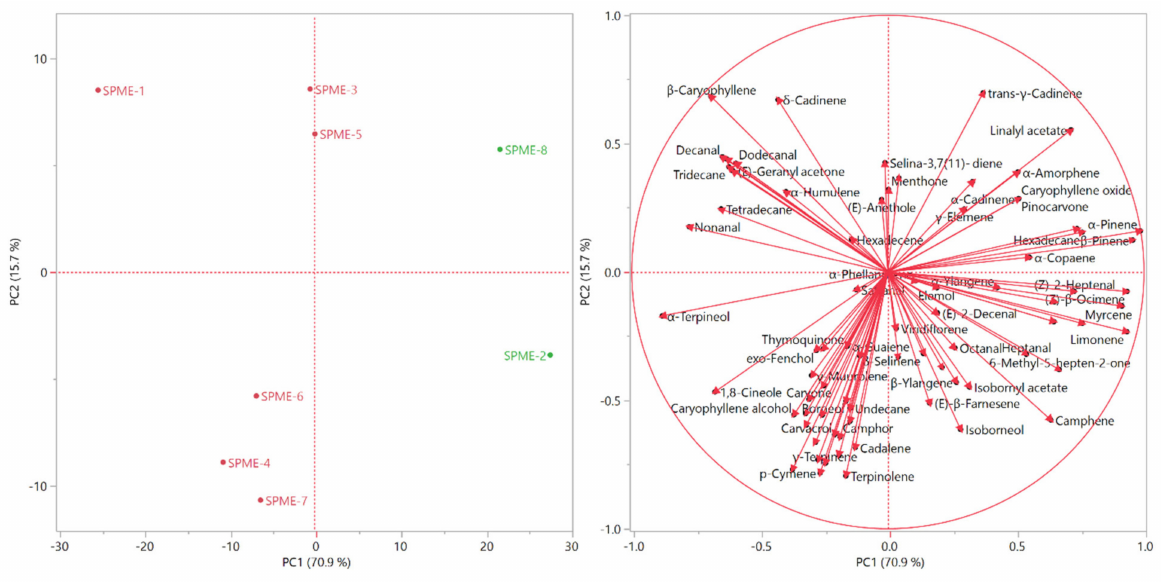
Figure 2. The score and the loading plot of the principal component analysis of Sumac volatile